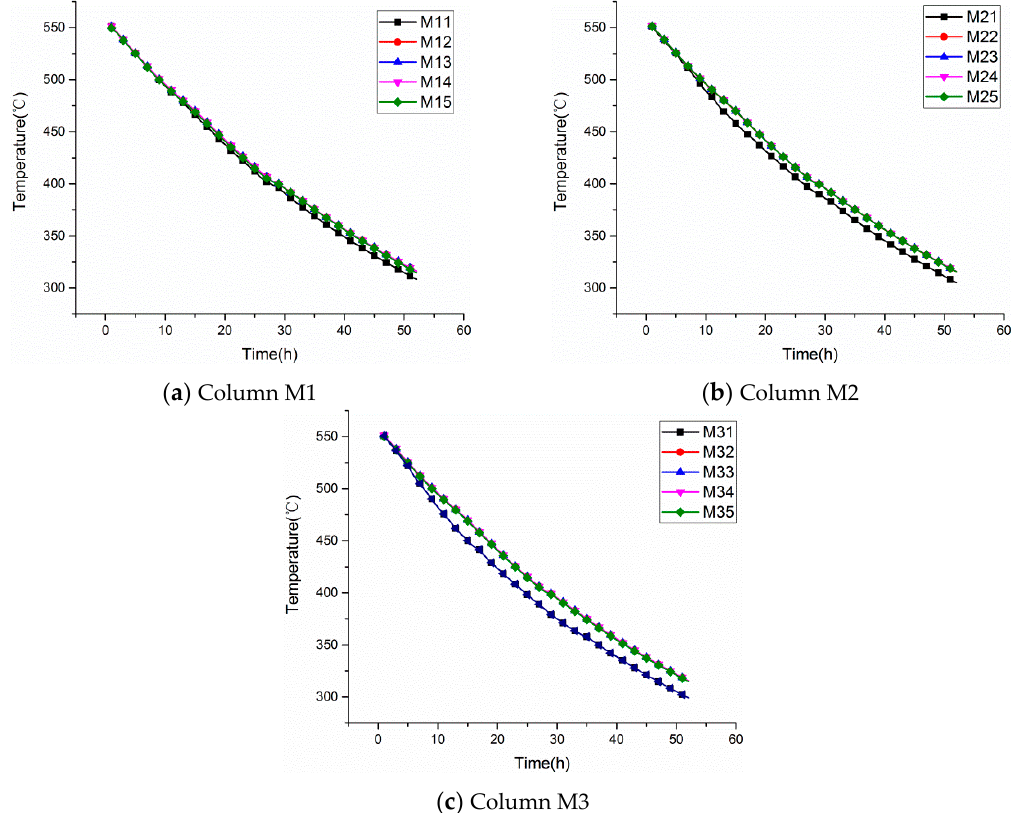
Figure 3. Temperature distribution of the molten salt during the cooling process from 550 to 300 °C.